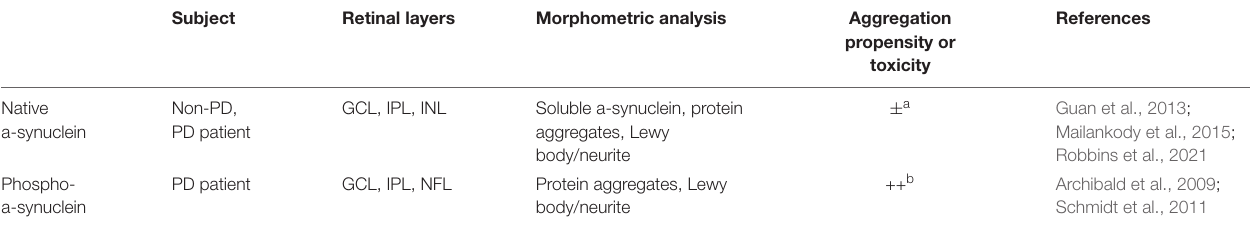
TABLE 2 | Table outlining the features of native and phosphorylated a-synuclein in the retina.